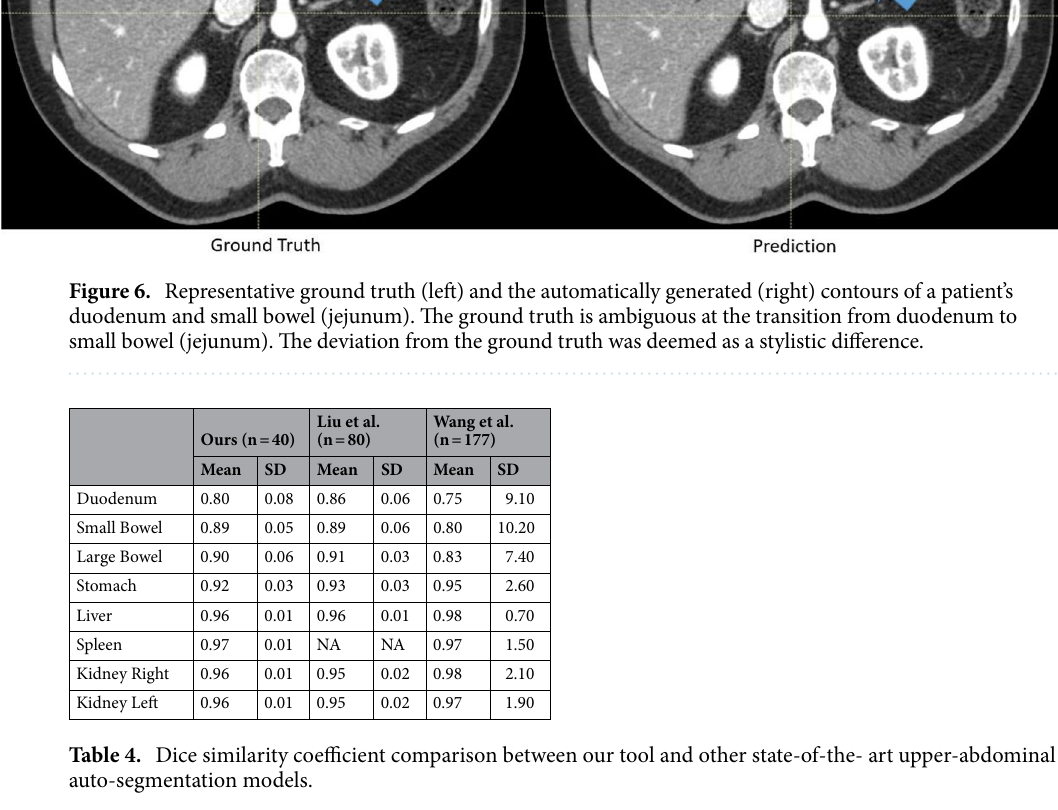
Ours (n = 40) Liu et al. (n = 80) Wang et al. (n =